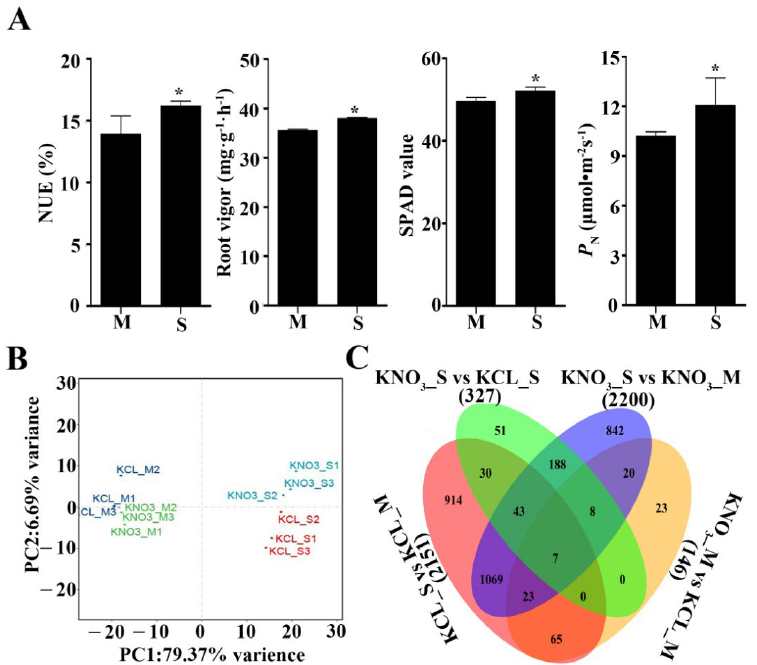
Figure 1. Analyses of nitrogen-related indices and comparison of four transcriptome libraries. ( A ) Analysis of NUE, root vigor, SPAD and P N of Shannong–1 and Maotao. Error bars show the